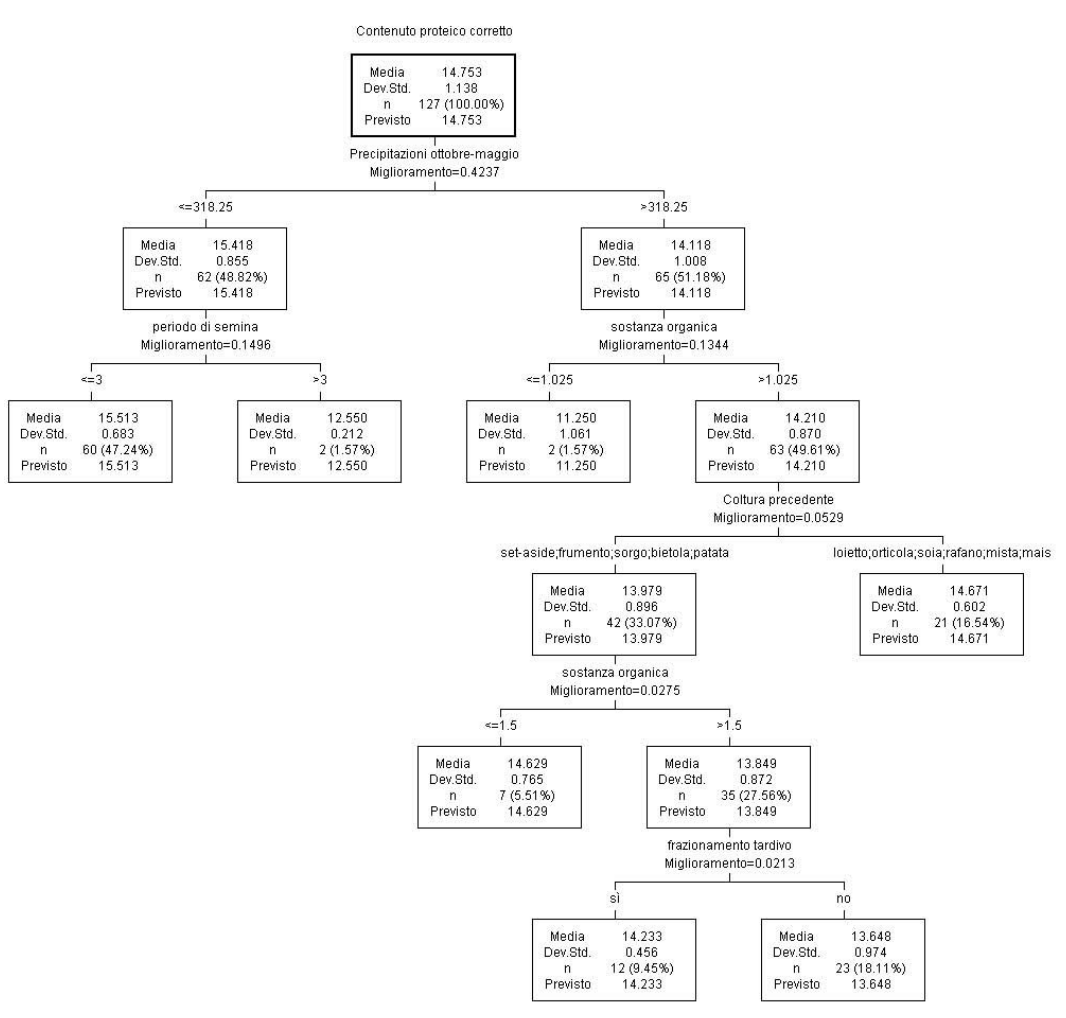
Figura 2 – L’albero di regressione ottenuto sui dati in